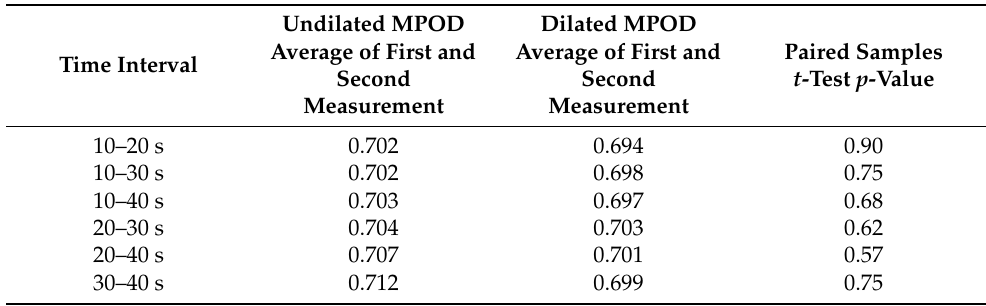
Table 4. Pearson correlation coefficient between mean MPS II-MPOD (macular pigment optical density) and mean MPR-MPOD obtained with and without pupillary dilation. R-Statistic Mean Undilated R-Statistic Mean Dilated Time Interval MPR-MPOD and Mean MPS MPR-MPOD and Mean MPS II MPOD II